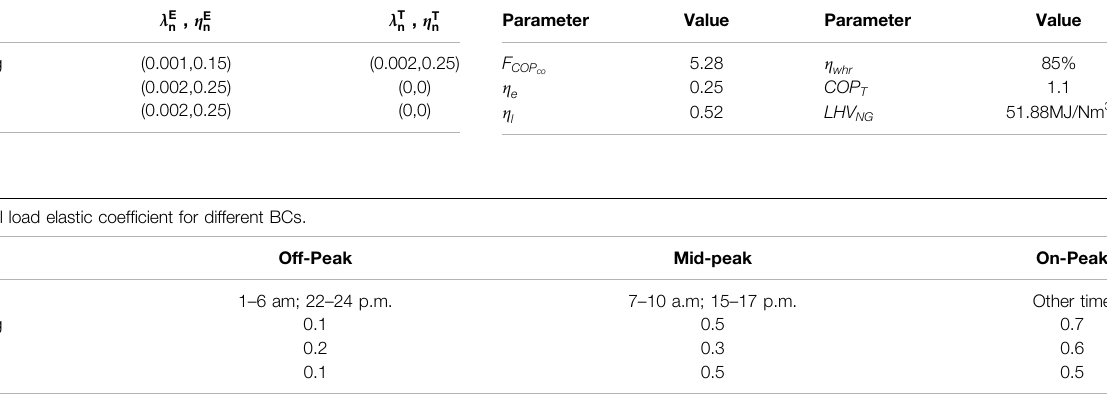
TABLE 5 | Load preference parameters of BCs.